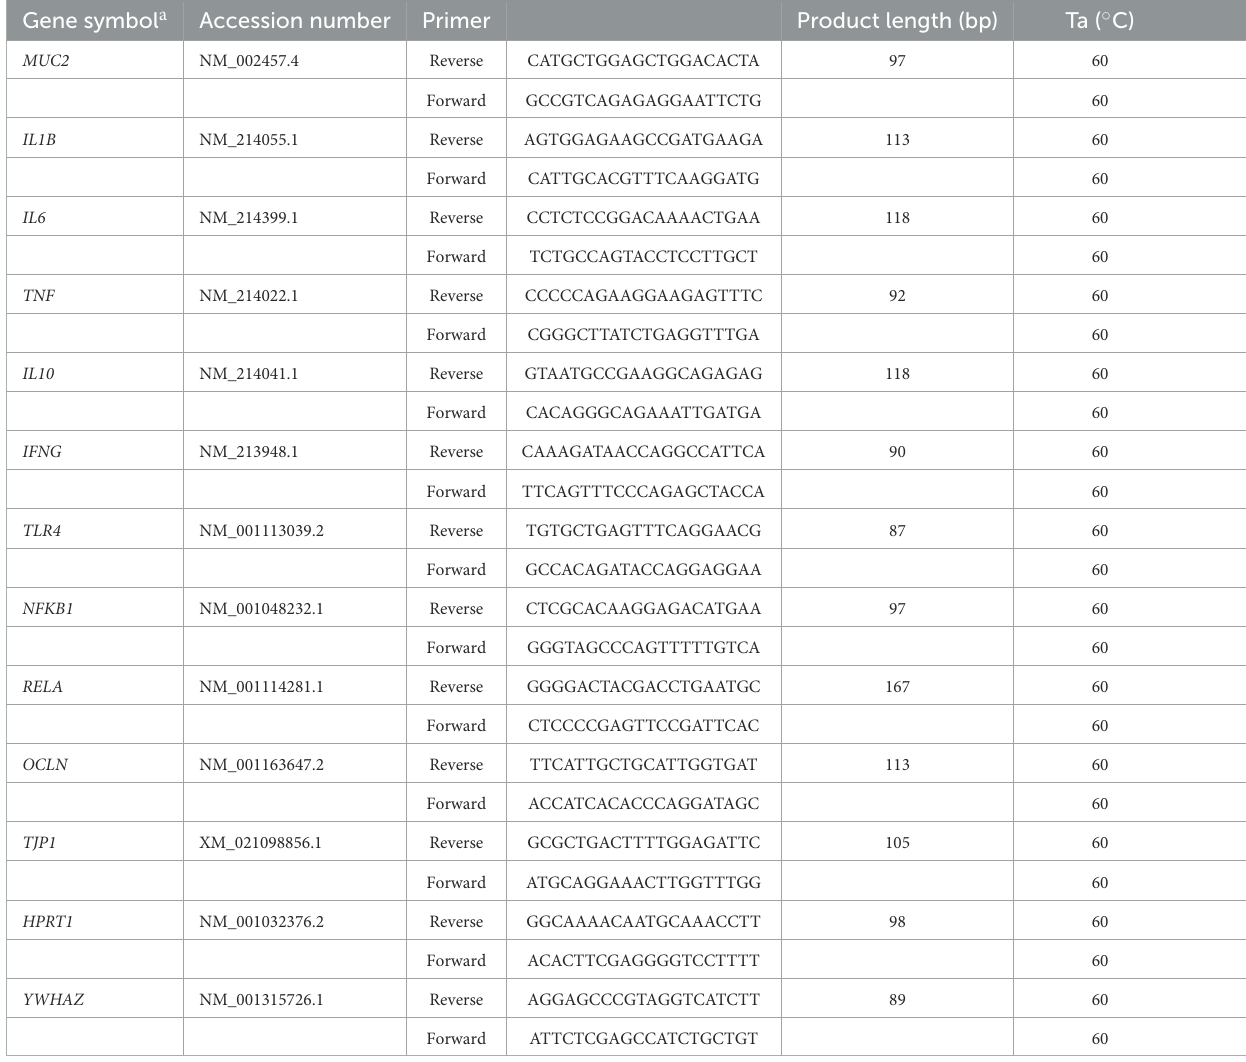
TABLE 2 Primer sequences used for reverse-transcription quantitative real-time PCR. Gene symbol